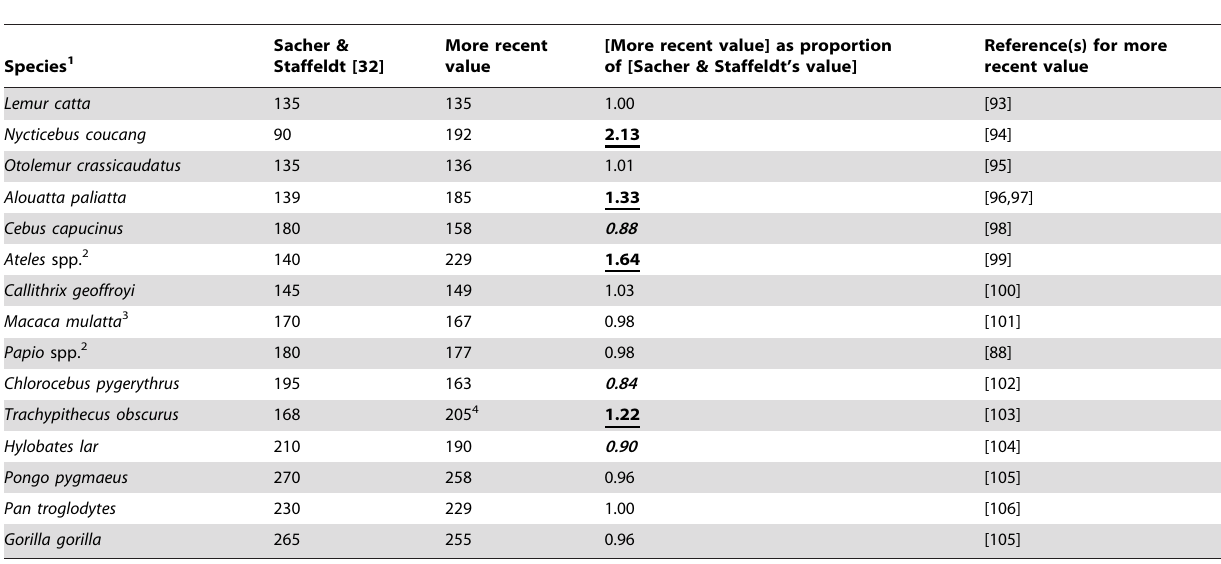
Table 1. Gestation length [days] in nonhuman primates as provided in Sacher & Staffeldt [32] compared to more recent values, for which conceptions were determined based on hormonal analysis or other physiological measures.